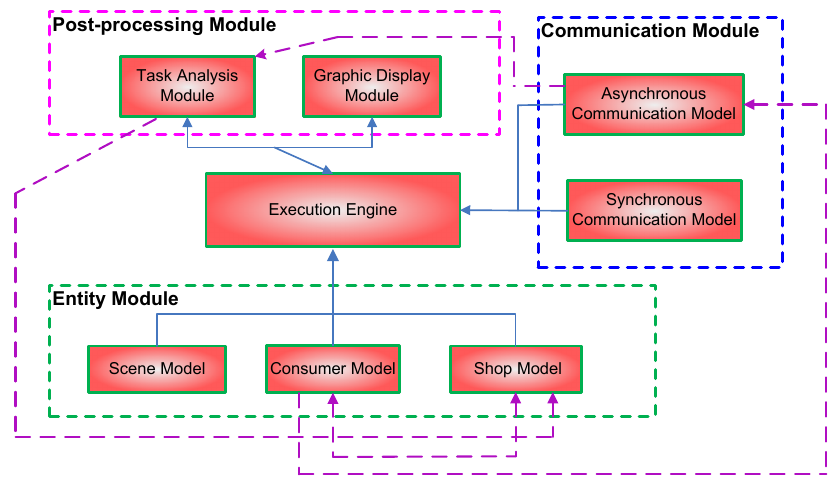
Figure 3. The architecture of the simulation system for mobile group consumption. The solid arrows represent data flows. The dashed arrows represent the influence between two